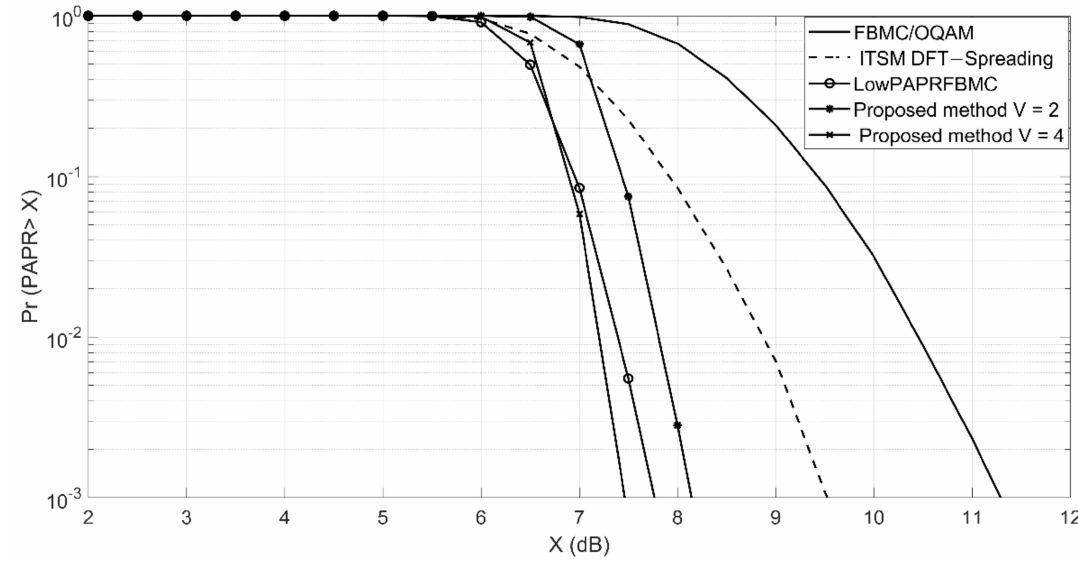
Figure 6. PAPR (peak-to-average power ratio) comparison of several reduction methods for N =